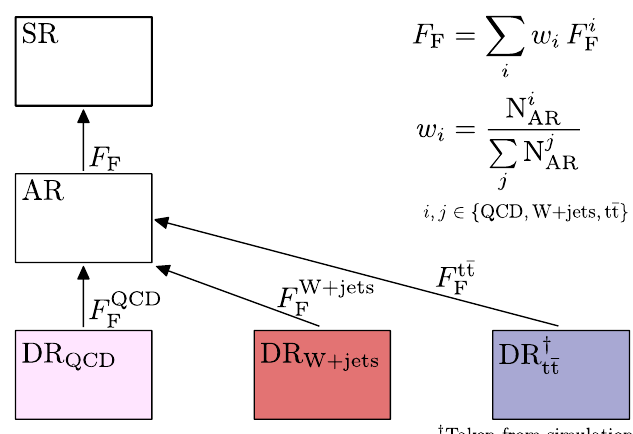
Figure 4 . Schematic view of the determination and application of the F i of the background from QCD multijet, W+jets, and tt events due to the misidenti(cid:12)cation of jets as hadronic (cid:28) lepton decays. Note that DR